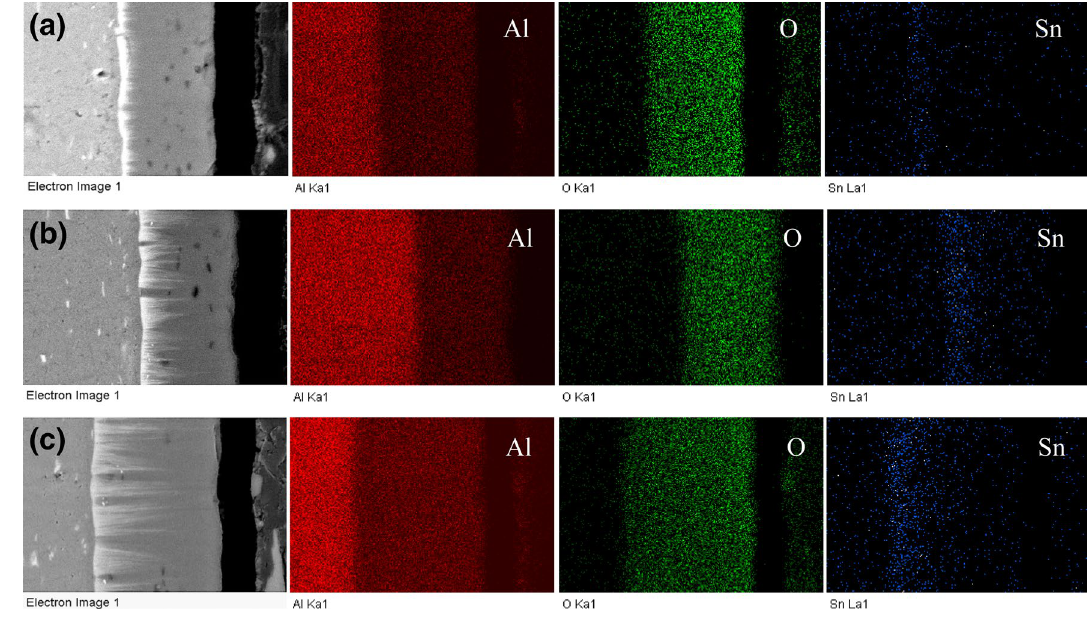
Fig. 4 SEM image and EDX mapping analysis of the a Sn–Al